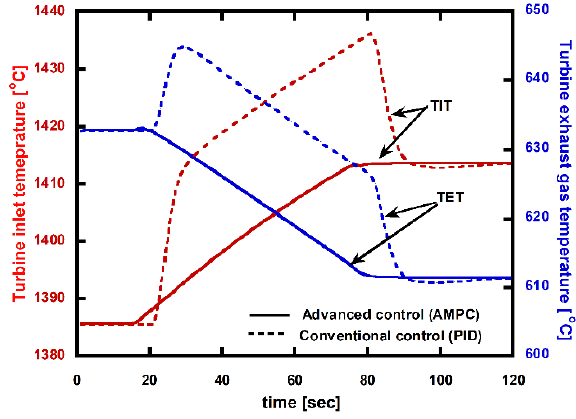
Figure 18. Simulated variations in gas TIT and TET with increasing load (ramp rate: 30 MW / min).